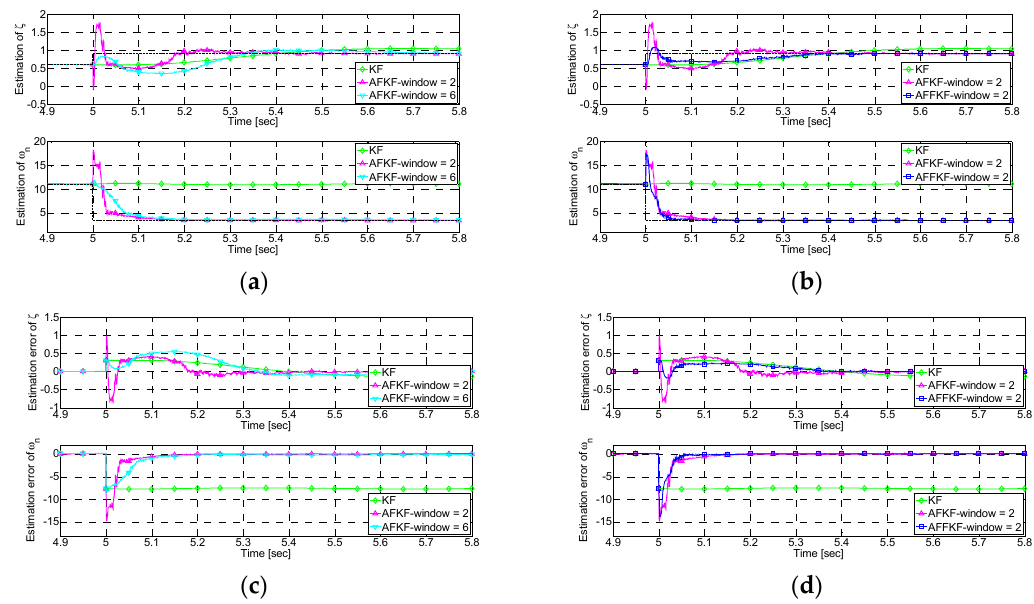
Figure 5. Results of estimation of abrupt fault parameter for linear system: ( a ) standard Kalman filter and AFKF, ( b ) the proposed AFFKF, ( c ) errors in estimation with standard Kalman filter and AFKF, ( d ) errors in estimation with the proposed AFFKF.